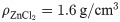
Peclet and Reynolds numbers.Peclet and Reynolds numbers for a spherical particle suspended in different salt solutions as a function of particle diameter. The graph shows pairs of curves of Peclet and Reynolds numbers for three different salt solutions typically used for extraction of plastics: NaCl, ZnCl2, and NaI. Curves were calculated using the following parameters (for details on how these parameters were obtained, see Section A in S1 Appendix): T = 25°C, ρNaCl = 1.2 g/cm3, ρZnCl2=1.6g/cm3, ρNaI = 1.8 g/cm3, ηNaCl = 1.76 mPa s, ηZnCl2=1.96mPas, ηNaI = 2.32 mPa s. For the density of the plastic particle we assumed ρ = 1.05 g/cm3 (polystyrene). Shaded ranges show validity of Stokes’ law for the ZnCl2 solution.